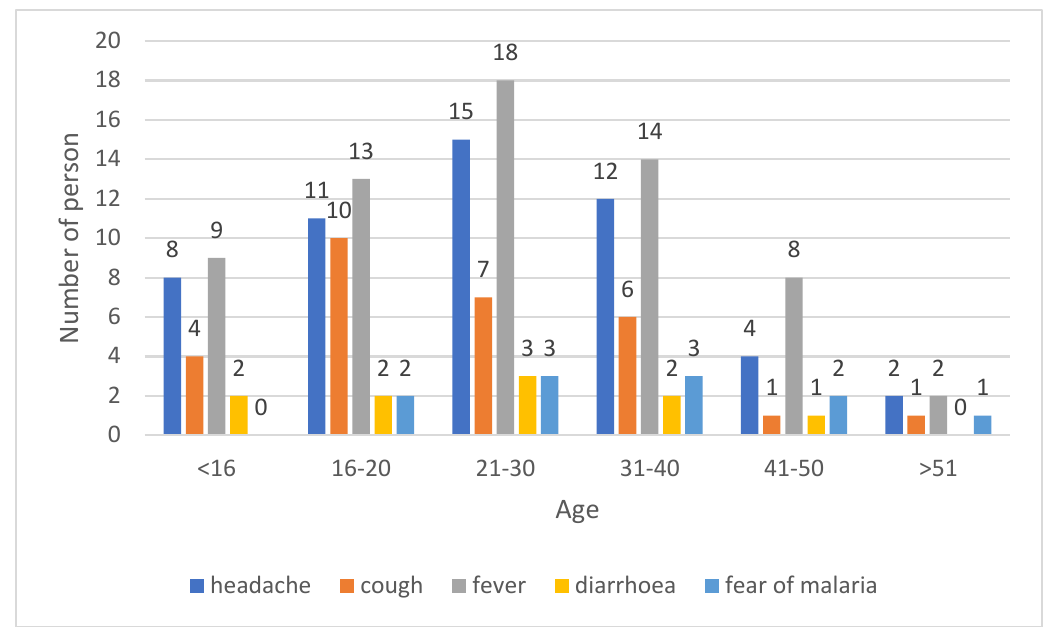
More than 20% of the respondents used the drug because of fever and headache; 4.4% of the respondents took the antimalarial drug only because they were afraid of malaria and had no symptoms of concern. There was no significant correlation between the reason for use and age ( p = 0.93) (Figure 5).